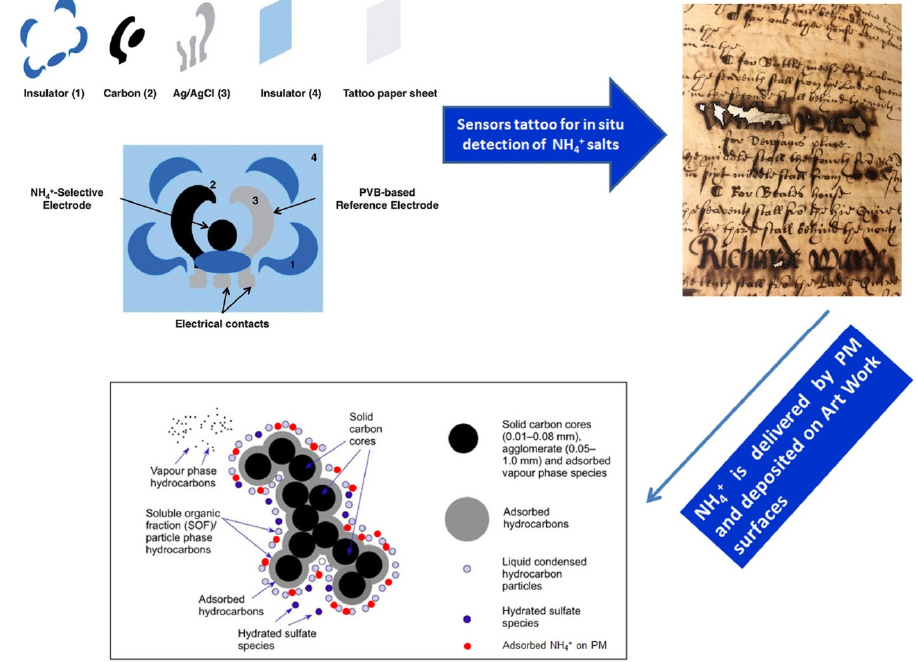
Figure 3. Layer ‐ by ‐ layer fabrication of the potentiometric tattoo sensor, as reported by Guinovart et al. [76]. The authors, display a cartoon to explain a future applications of tattoo sensors for the “ in situ ” detection of adsorbed pollutants and damages, on the CH surfaces.